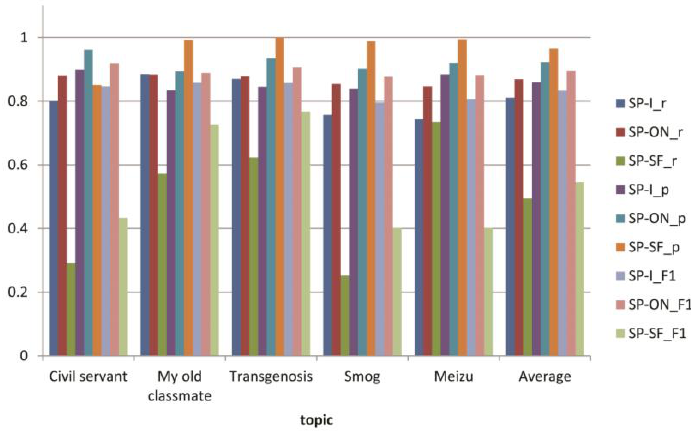
Figure 5. Topic tracking performance when the similarity threshold is equal to 0.15.